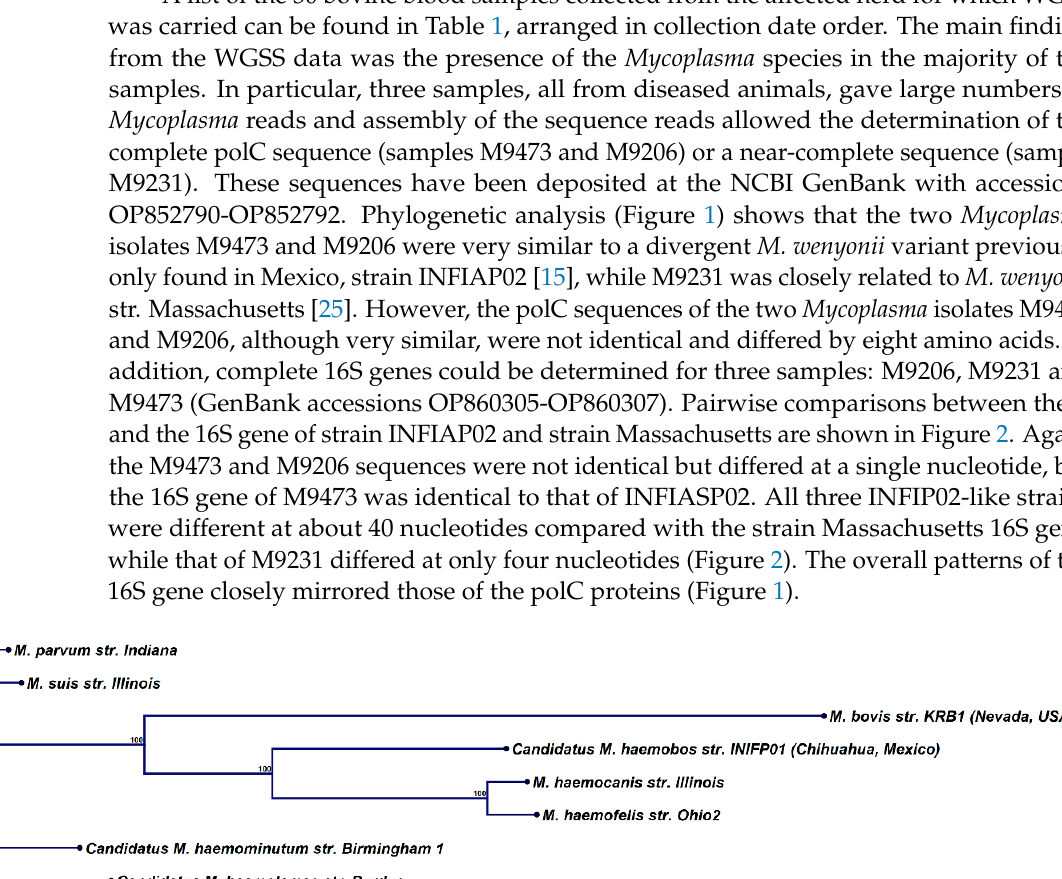
Figure 2. Pairwise comparison of the complete 16S gene of the three Mycoplasma isolates M9473, M9206 and M9231 characterised in the present study and the 16S gene of the strains INIFAP02 (NZ_QKVO00000000) and Massachusetts (CP003703). Above the diagonal, the numbers of differences are shown and below the diagonal the percentage identity. Red and blue colour indicate high (<12 differences; >99.5% identity) and low (>24 differences; <98.1% identity) similarity, respectively. Another significant finding from the WGSS data were contigs classified as A. phagocytophilum in samples M9336 and M9337. Two contigs of M9336 with lengths of 514 and 430 nt and a single 461 nt contig from sample M9337 were 98%, 99% and 99% identical over the complete contigs lengths, respectively, to the strain Norway variant2 (GenBank accession CP015376) isolated from sheep in Norway in 2010. A third 616 nt contig from M9336 was 99% identical to the strain Norway variant1 (GenBank accession CP046639) over 71% of the contig length (data not shown). The PCR analyses detected A. phagocytophilum in 35% of the diseased cattle and in 40% of the healthy cattle (Table 1). No relevant virus sequences were found in any of the 30 bovine blood samples analysed. There was no evidence of a presence of Babesia in the WGSS data. All 84 serum samples investigated for antibodies against A. phagocytophilum were positive. In total, 22 samples were investigated for antibodies to B. divergens and none of these samples were positive. 3.2. Mycoplasma wenyonii real-time PCR As mentioned above, three distinct Mycoplasma were detected in the herd. An examination of the polC gene of the two INIFAP02-like Mycoplasma (M9473 and M9206) showed that no published PCR system was available for the detection of these variants